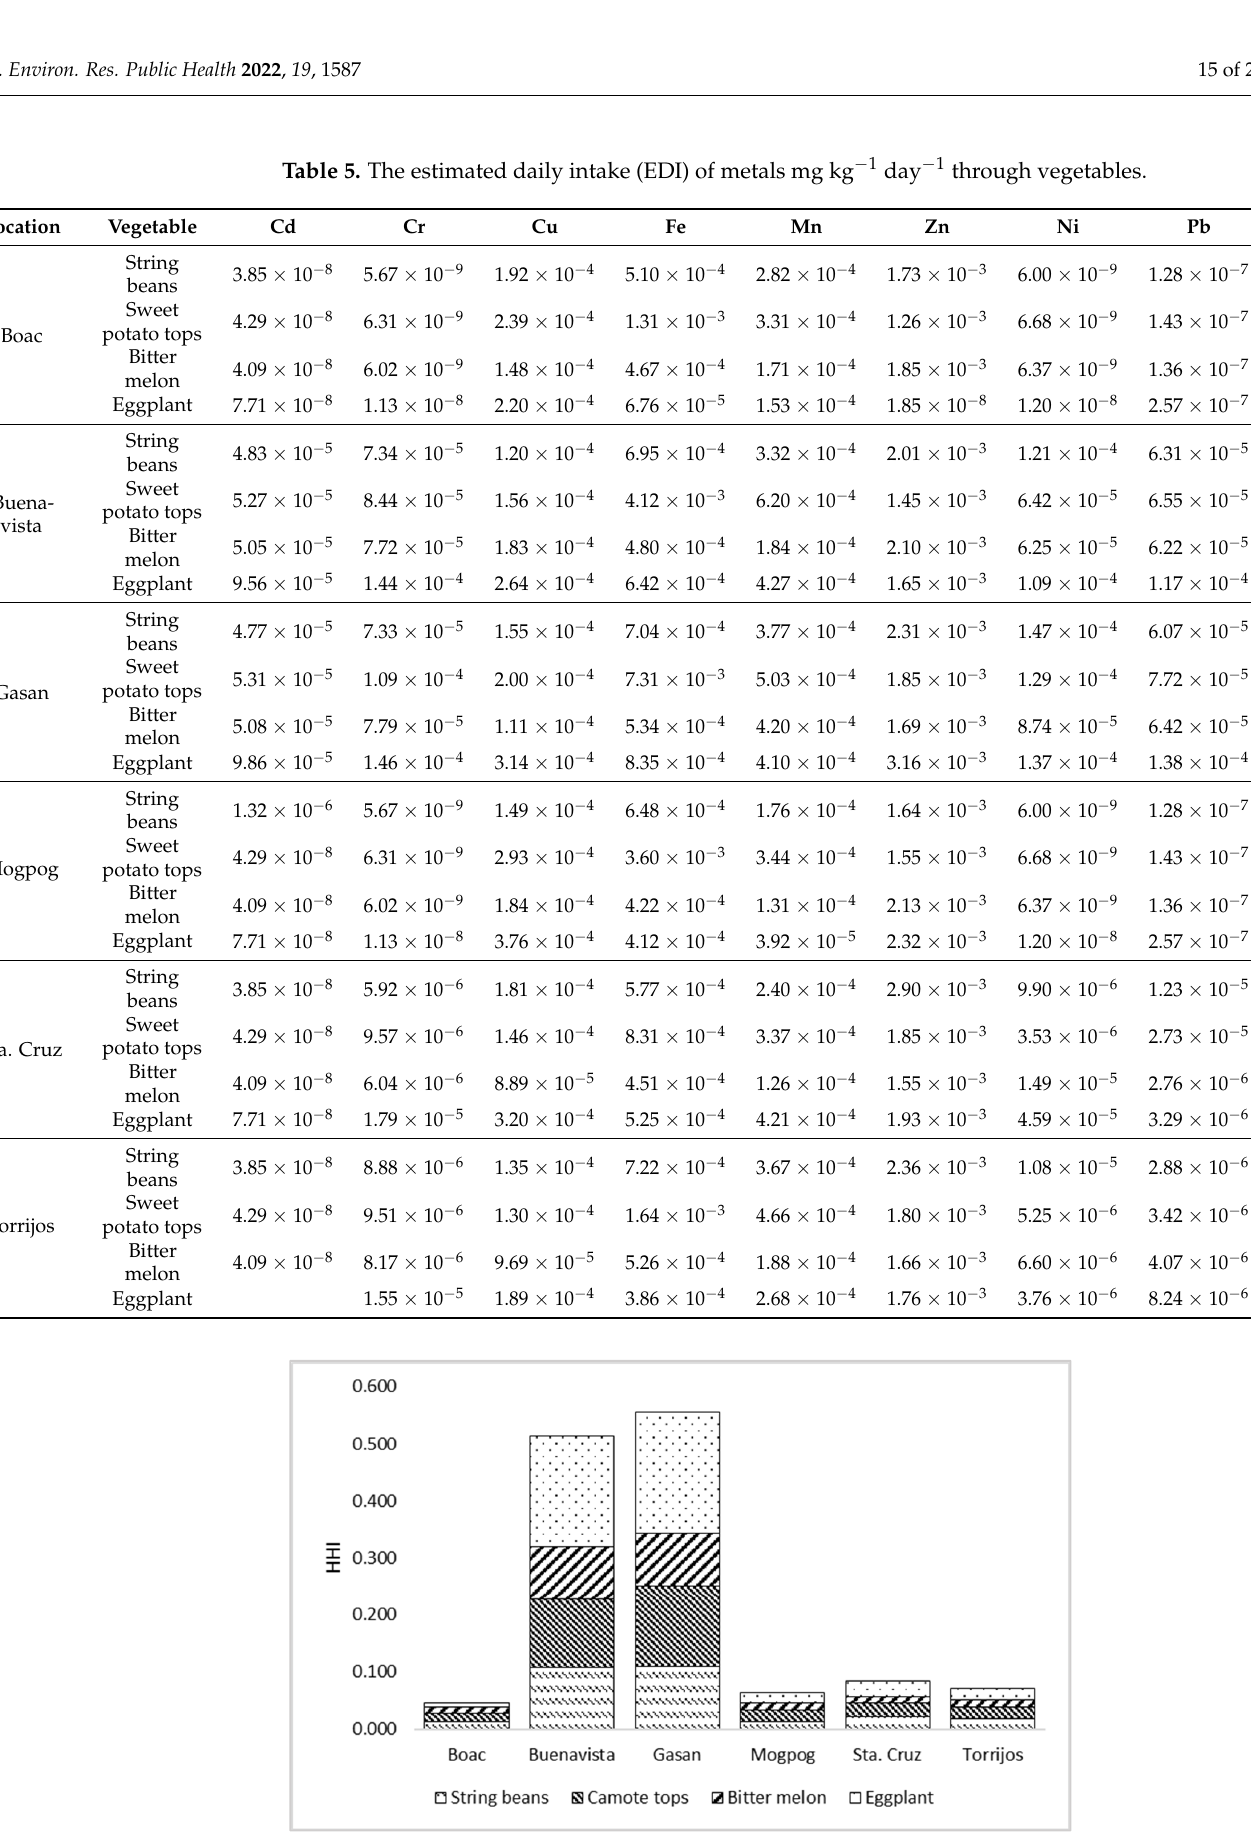
Figure 6. Potential health hazard index (HHI) by ingestion of vegetables from Marinduque.